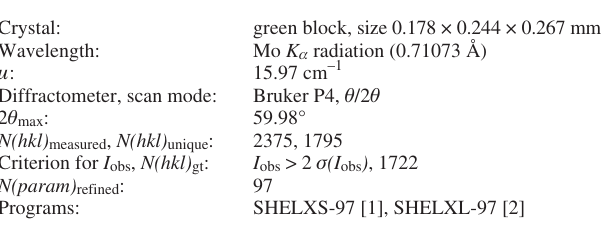
Table 1. Data collection and handling.